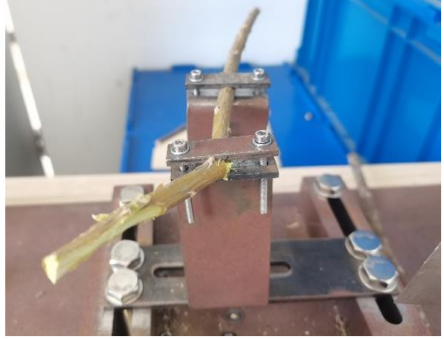
Figure 20. Unsupported cutting (moisture content of